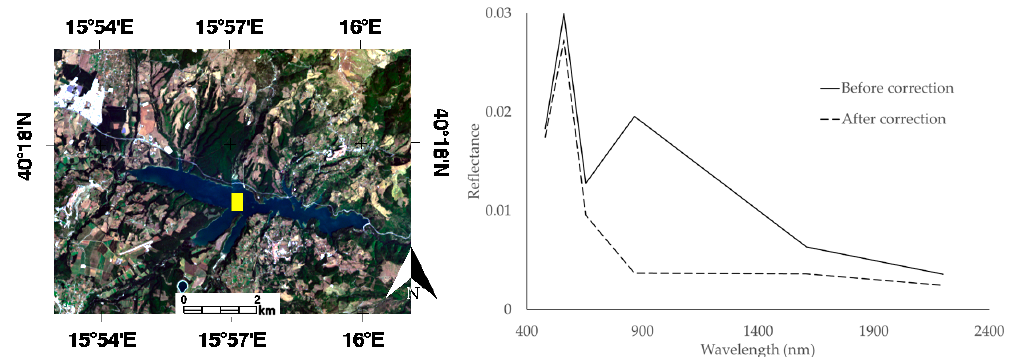
Figure 10. Landsat-8 image of Pertusillo Lake; in the graph, mean spectra of center lake deep water before (solid line) and after (dashed line) the application of the comprehensive correction procedure are shown.